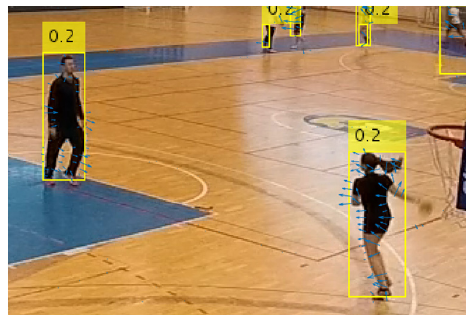
Figure 5. Player bounding box (yellow) and optical flow vectors (blue).